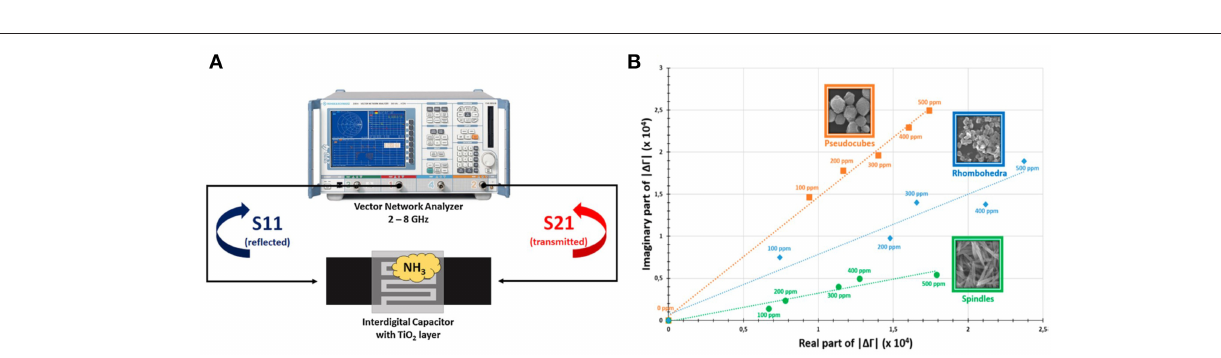
FIGURE 3 | (A) Principle of microwave transduction applied to reflection/transmission measurements, (B) response and recovery times for a microwave sensor exposed to ammonia. Reproduced with permissions from Bailly et al. (2016b,c). Copyright 2016 Elsevier; copyright 2016 American Chemical